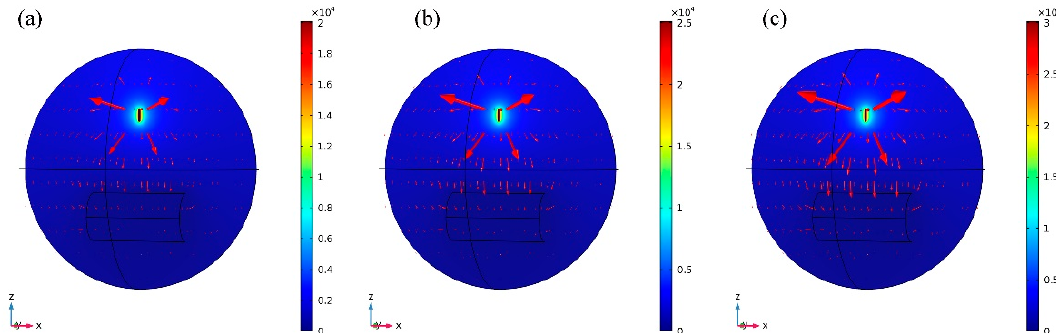
Figure 5. Electric field distribution at different voltages with receiving distance of 150 mm: ( a ) 20 kV, ( b ) 25 kV, and ( c ) 30 kV.